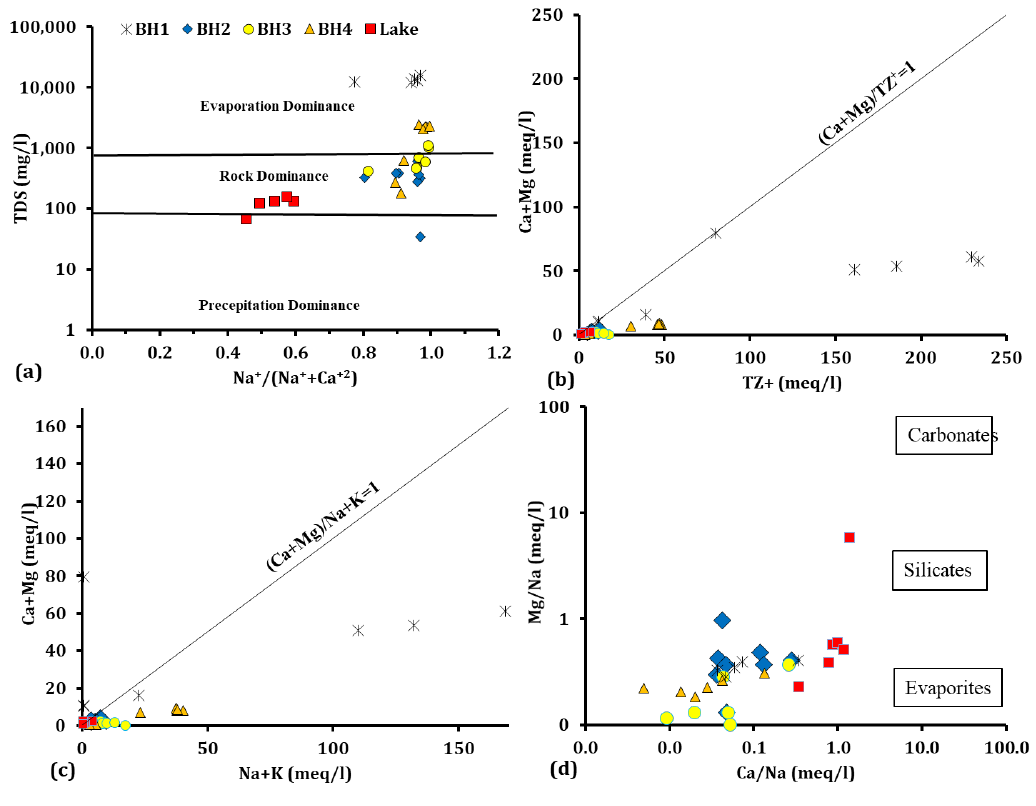
Figure 10. ( a ) Gibbs’ diagram representing the ratio of (Na + )/(Na + + Ca 2+ ) as a function of TDS,